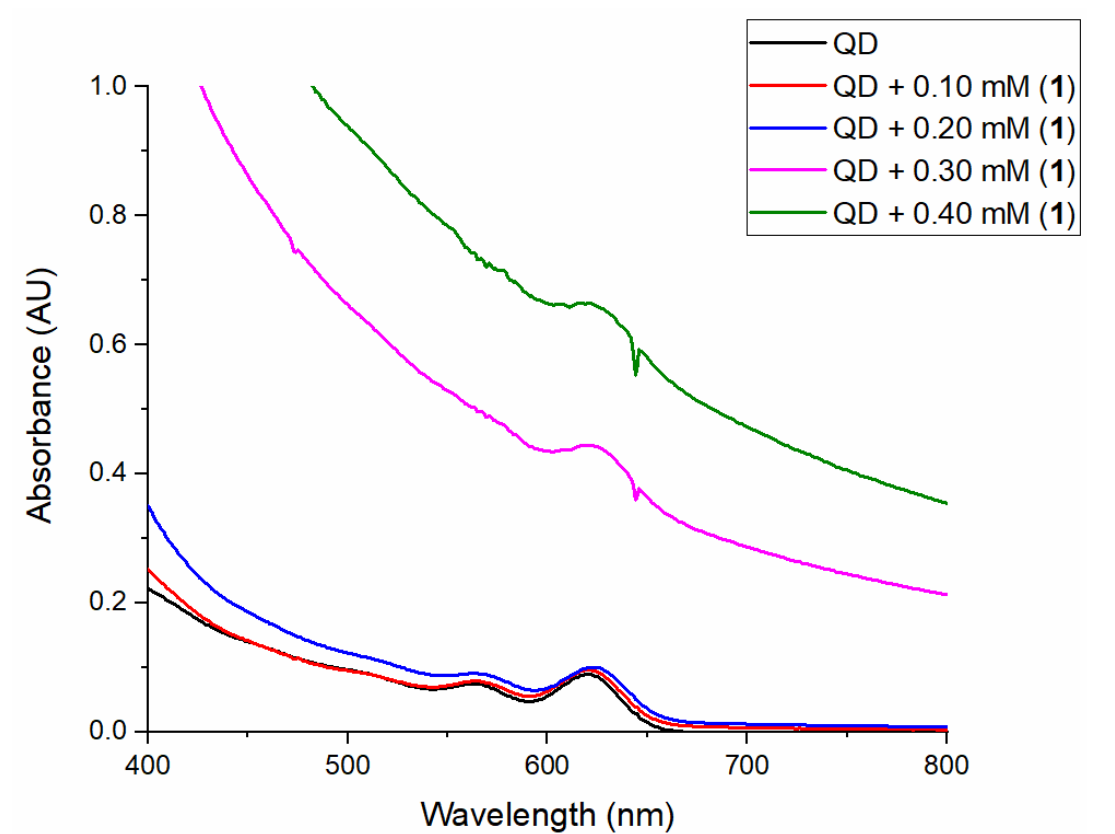
Figure 6. Optical spectra of the MPA–CdTe QDs with increasing concentration of 1.